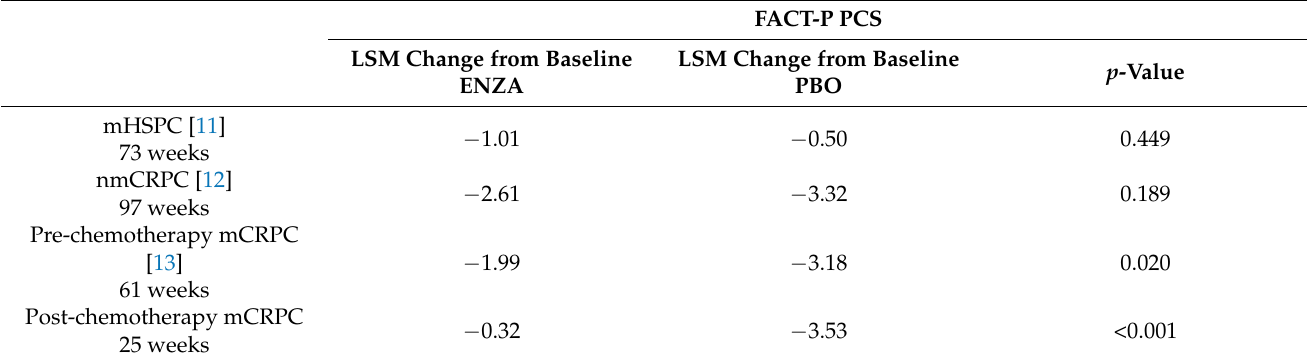
Table A4. Change from BL in prostate cancer symptom scores.